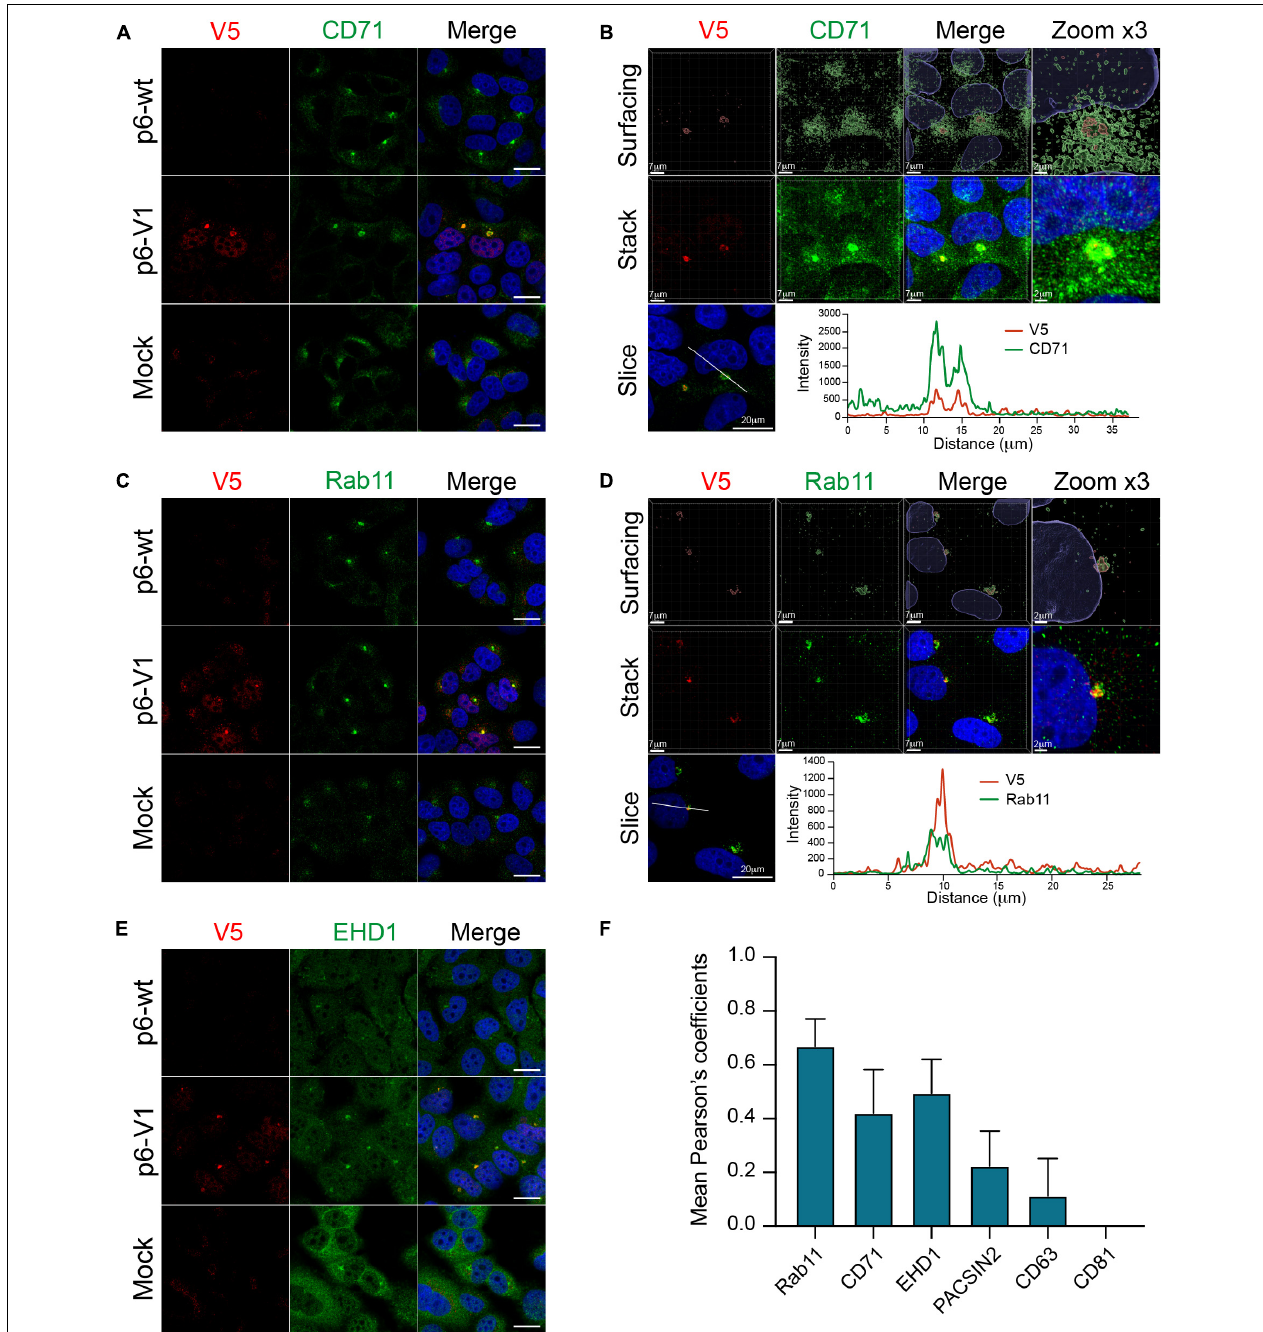
FIGURE 9 | Co-labeling of the HEV V5-tagged ORF1 protein with several cellular markers. The wt (p6-wt) and V5-tagged (p6-V1) ORF1 proteins were expressed in PLC3 cells electroporated with the p6 HEV strain. Three dpe, cells were co-labeled with anti-V5 antibody (red) and cellular markers antibodies (green) directed against CD71 (A,B) , Rab11 (C,D) , EHD1 (E) . Cell nuclei were stained with DAPI (blue). Mock-electroporated cells served as negative controls (Mock). Images were taken with a confocal microscope. Antibodies used are listed in Table 2 . Scale bar = 20 µ m. PLC3 cells electroporated with p6-V1 and co-stained with anti-V5 and antibodies directed against CD71 (B) and Rab11 (D) were analyzed by confocal microscopy with a high resolution Airyscan module. On the top, volume rendering of the 3D z-stacks (Surfacing) using the Imaris software are shown to visualize the V5-tagged ORF1/CD71 or Rab11 substructures. In the middle, z-stacks are shown. On the bottom, line graphs show the fluorescence intensities of V5-tagged ORF1 and CD71/Rab11 staining measured every 50 nm across the region of interest highlighted by the white line in the micrograph shown on the left. Scale bars show the indicated length. (F) Regions of interest (ROI) were drawn around the perinuclear nugget-like structures on the immunofluorescence images of p6-V1 electroporated PLC3 cells co-labeled with antibodies directed against the V5 epitope and CD71, Rab11, EHD1 (A,C,E) and PACSIN2, CD63 and CD81 ( Supplementary Figures 3D–F ). Thirty ROI were used to calculate PCC ( ± standard deviation) using JACoP plugin from ImageJ